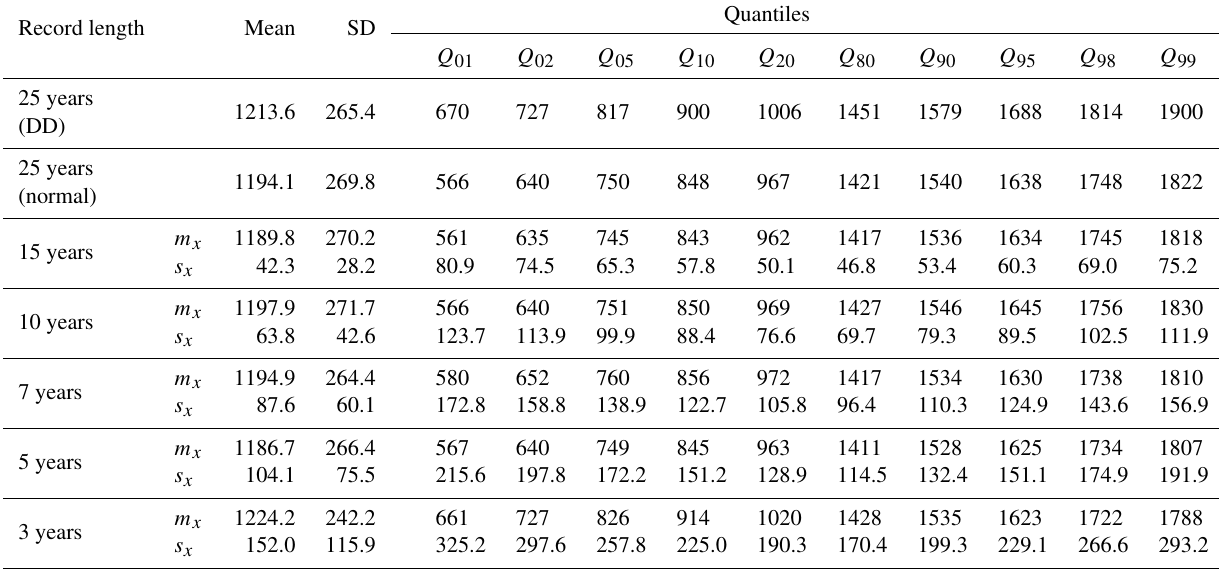
Table A2. Mean, standard deviation (SD), and selected quantiles of the annual rainfall in Concepción (in millimeters), as obtained by fitting normal distributions to the complete 25-year record, and to the same 200 resampled, shorter records as in Table A1 ( m x and s x are the mean and standard deviation of each statistic, for the 200 resampled records; note that the results with the DD approach, for the complete record, are given in the first row for